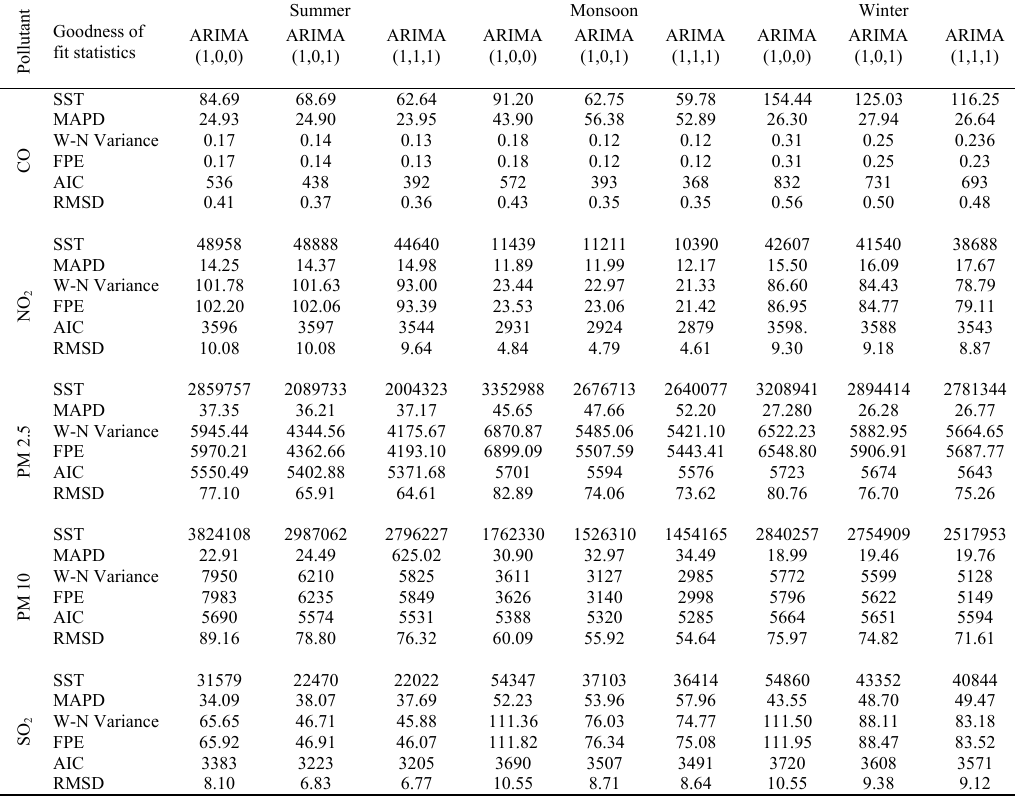
Table 2: Goodness of fit statistics of different ARIMA models for pollutants with 95 % confidence